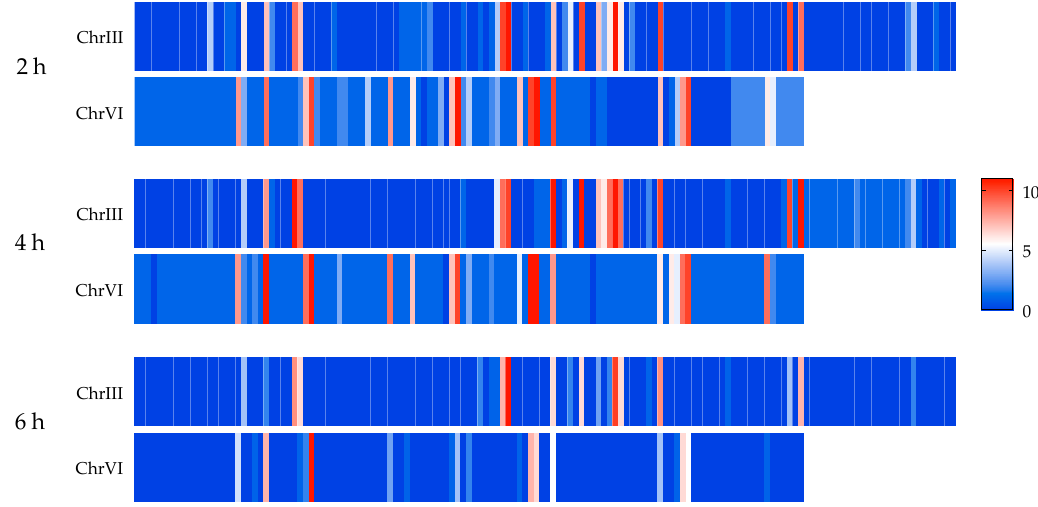
Figure A3. Heat maps of gene loss frequencies in three sets of randomly selected white SCRaMbLEd EW01-GAL. Each segment represents a coding DNA sequence (CDS) on synthetic chromosomes III and VI, while the color depicts the total number of CDS lost by SCRaMbLEing; blue segments depict sites of minimal deletion while red represents the most frequent deletion sites.